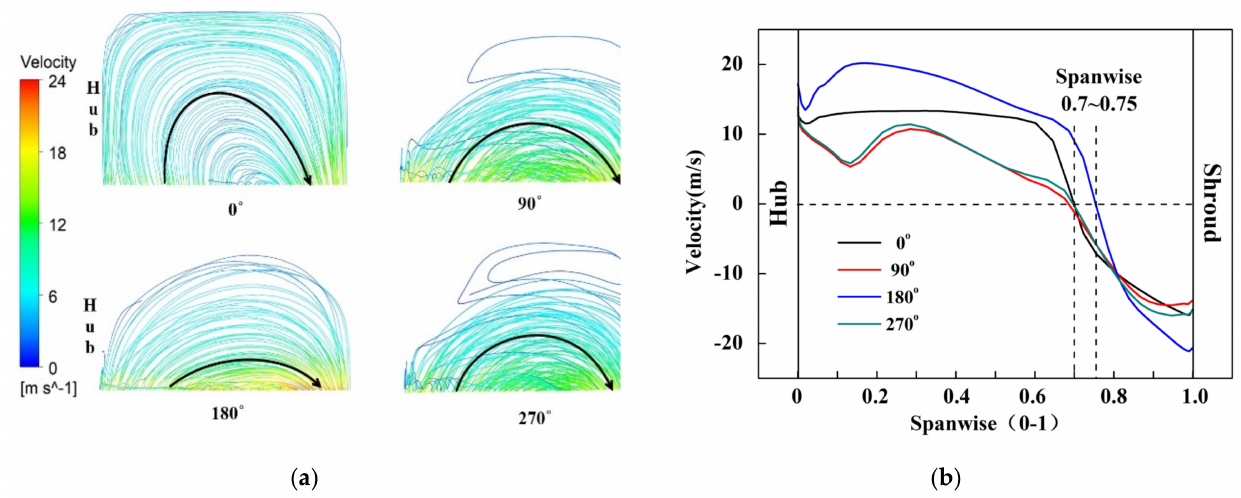
Figure 7. ( a ) The streamline in the self-induced slot and ( b ) the velocity distribution in the SIS model.